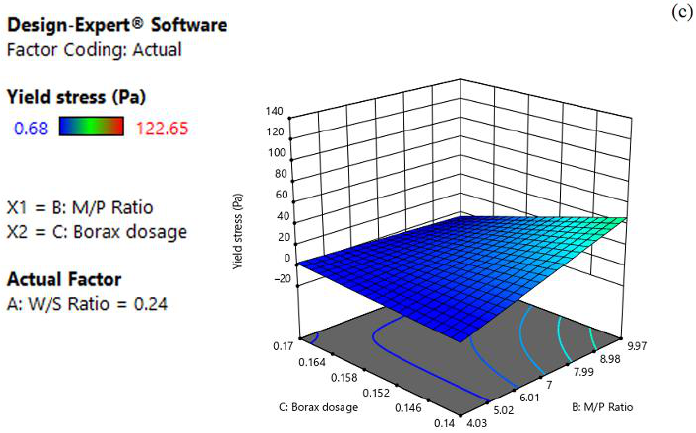
Figure 5. Three-dimension response surface plots of yield stress (Y 3 ) in relation to: ( a ) W/S ratio (X 1 ) and M/P ratio (X 2 ); ( b ) W/S ratio (X 1 ) and borax dosage (X 3 ); ( c ) M/P ratio (X 2 ) and borax dosage (X 3 ).